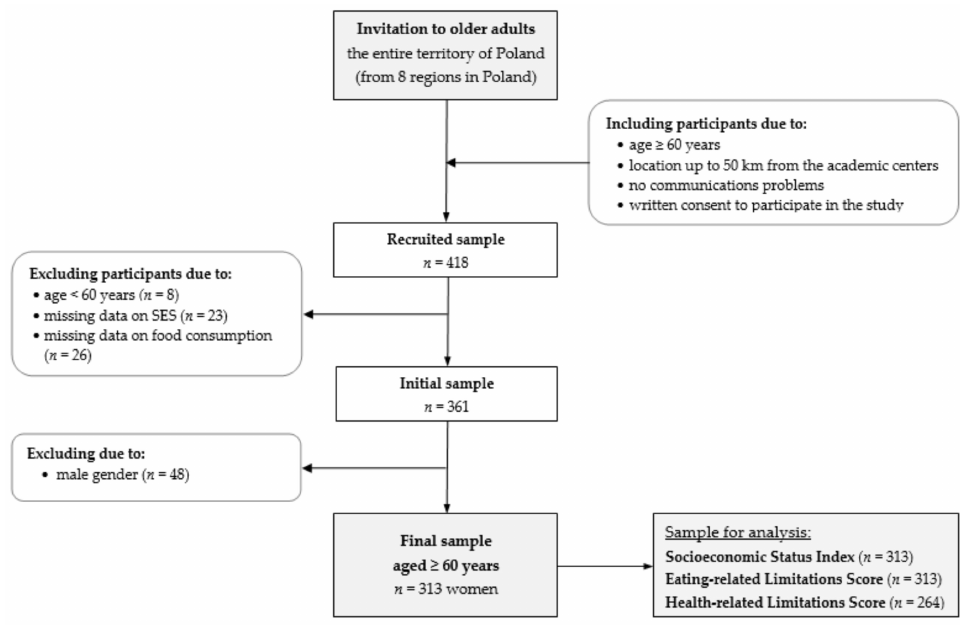
Figure 1. Flowchart of study design and sample collection. Notes: SES—socioeconomic